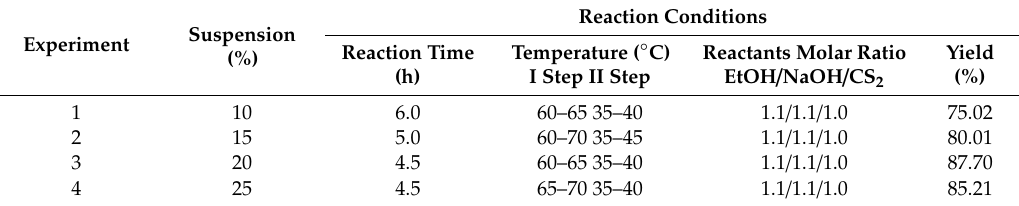
Table 4. Dependence of Na-EtX yield from product suspension